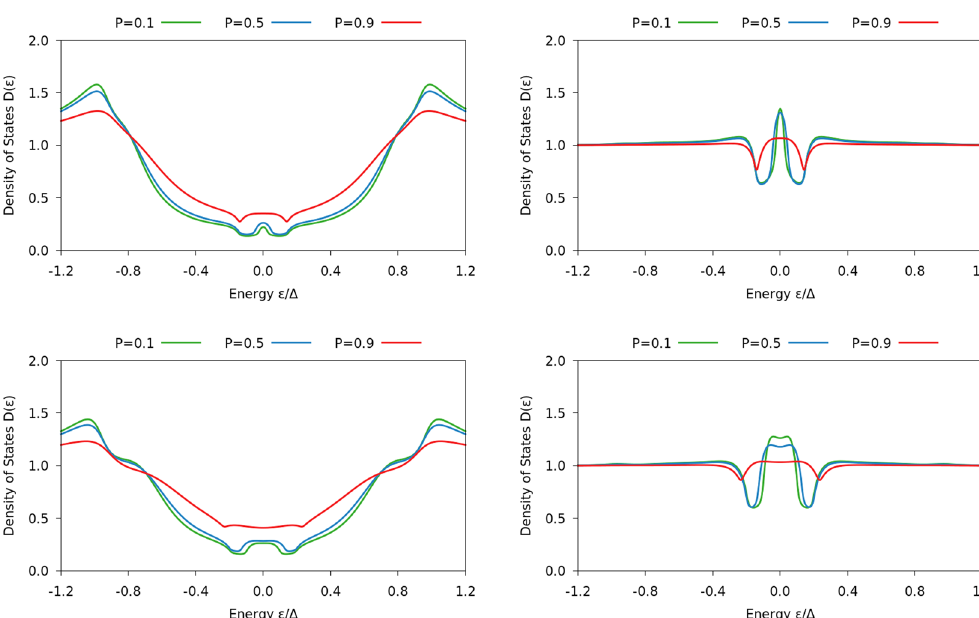
Figure 3. Plots of the DOS for an S/FI/N junction with L S = L N = ξ S as function of energy. The left column shows the results on the superconducting side of the interface, and the right column on the normal-metal side. The spin-mixing conductance G ϕ / G 0 is 0.75 in the top row and 1.25 in the bottom row, while the interface polarization P is written in the